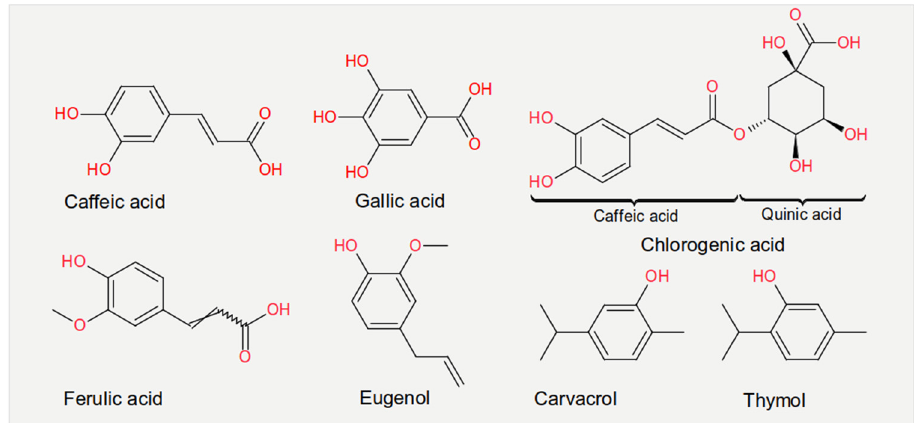
Figure 3. Chemical structures of the phenolic acids reported in the present review.